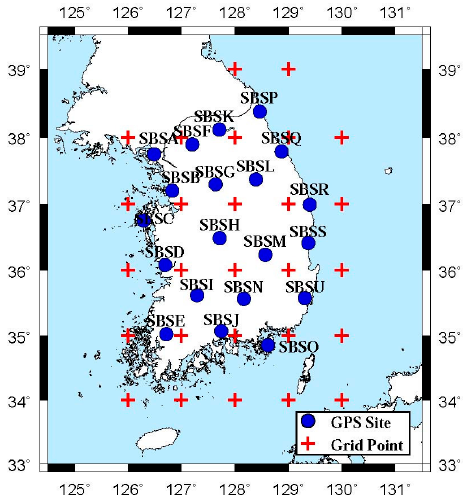
Figure 1. Location of 20-site PPP-RTK network in South Korea. The red crosses denote positions where gridded ionospheric and tropospheric delay corrections are generated in SSR format. The average inter-site distance is ~70 km.